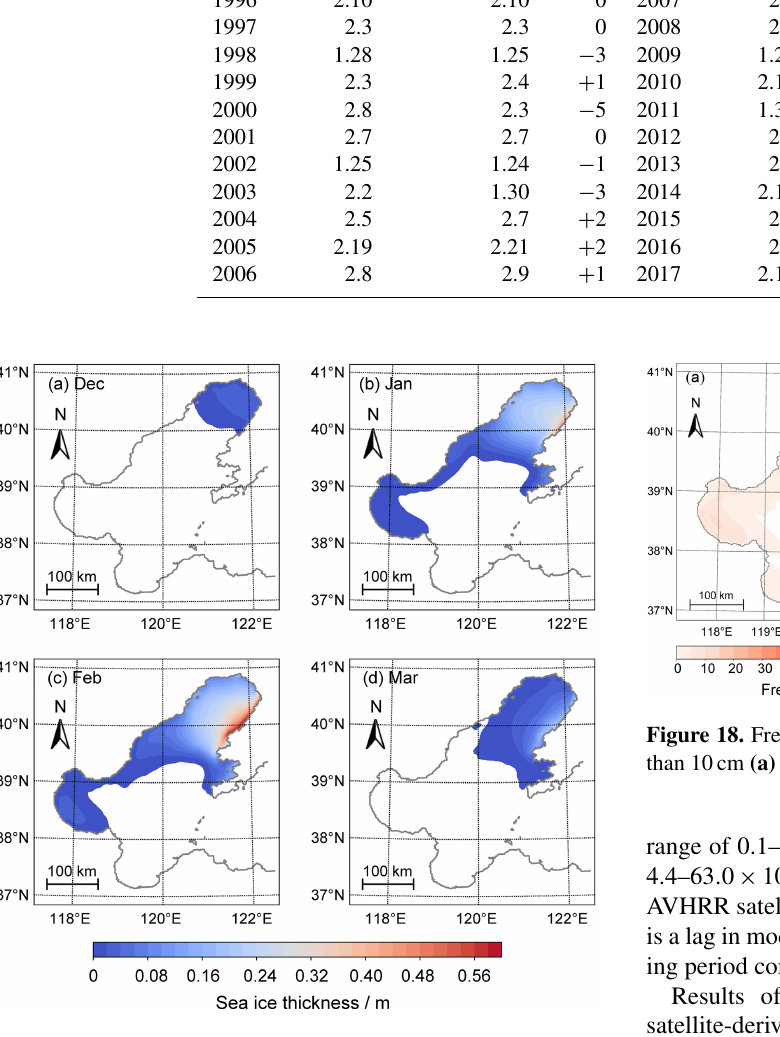
Figure 17. Similar to Fig. 16 but for sea ice thickness.